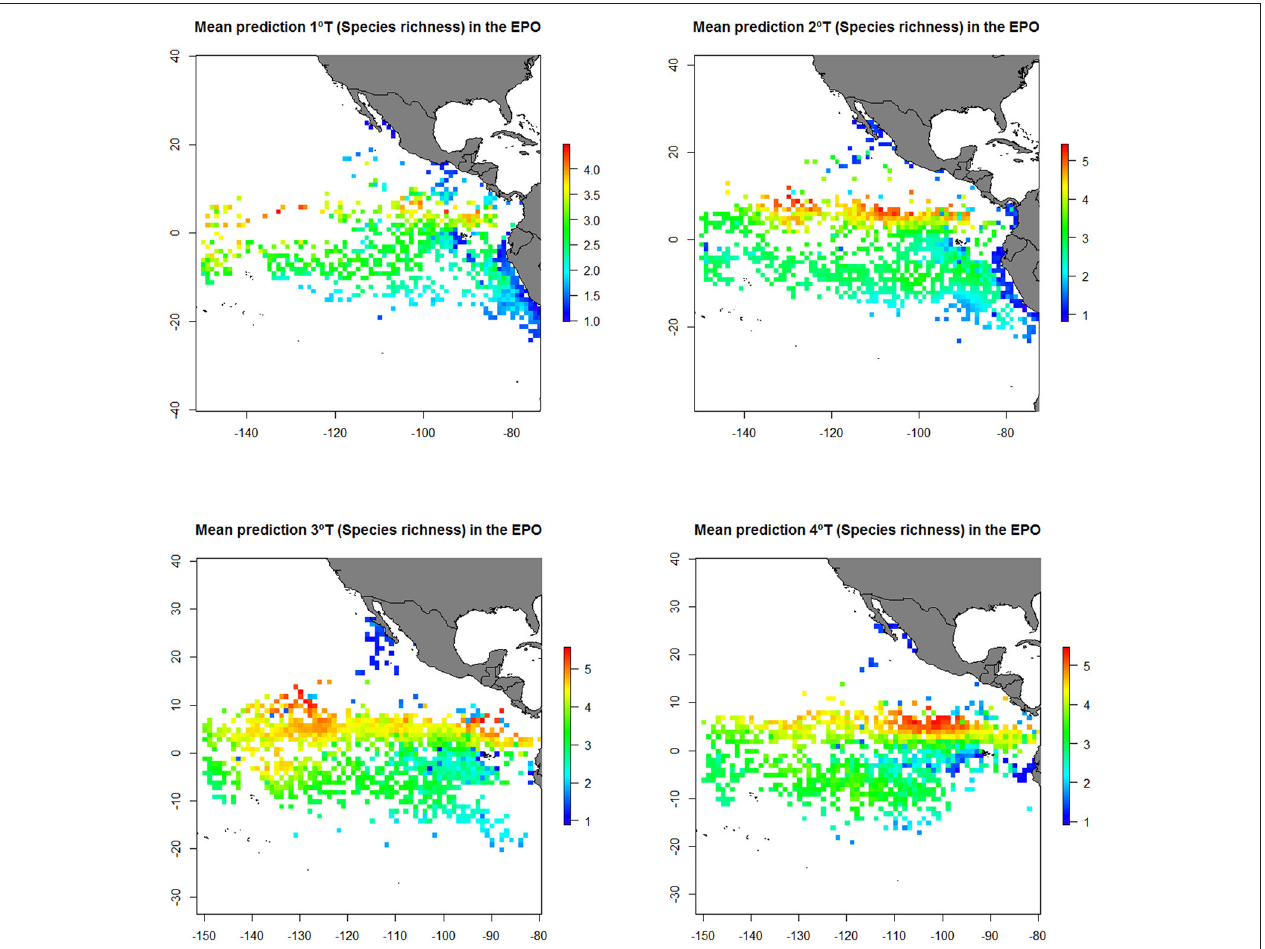
FIGURE 6 | Predicted diversity (Species richness index) of the bycatch assemblages in FAD and School sets in the eastern Pacific Ocean (EPO) from the generalized additive model (GAM). Mean prediction for the first (1st T), second (2nd T), third (3rd T) and fourth trimester (4th